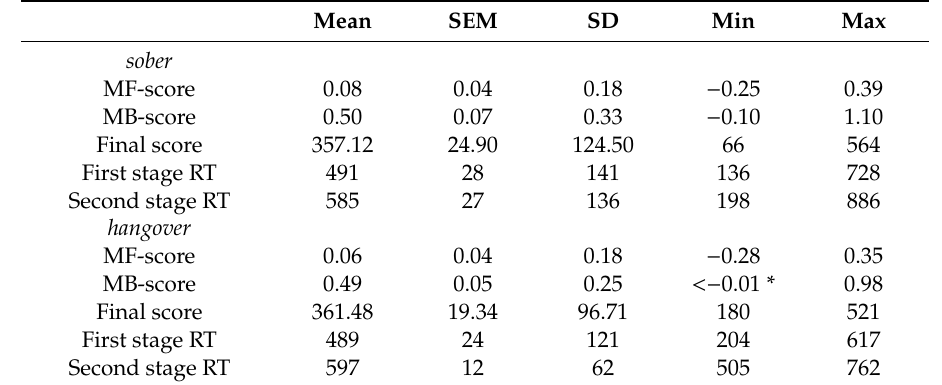
Table 2. Descriptive task statistics for the two-step decision-making task for the sober and hangover session.